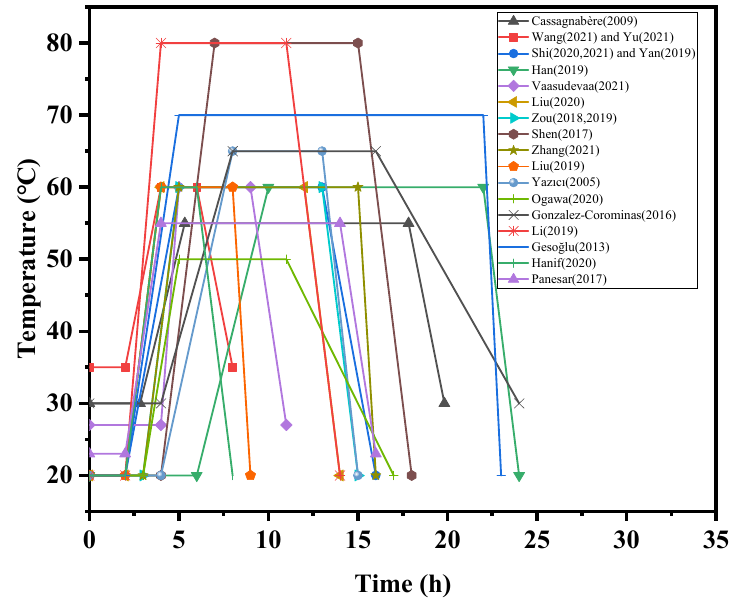
Figure 9. Treatment time of steam-cured concrete at different stages [7–9,21,25,28,29,44,47,54,56,59,60,65,67,72,73,75,82–87].